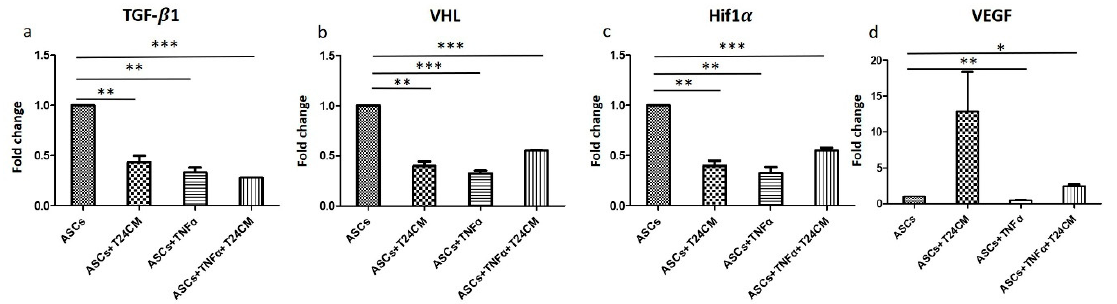
Figure 11. Downregulation of tumorigenesis-related growth factors including ( a ) TGF- β 1, ( b ) VHL, ( c ) Hif1 α , and ( d ) VEGF in ADSCs and TNF- α -treated ADSCs cultured with bladder cancer cells (T24 cells) medium for 24 h (* p < 0.05, ** p < 0.01, *** p < 0.001).